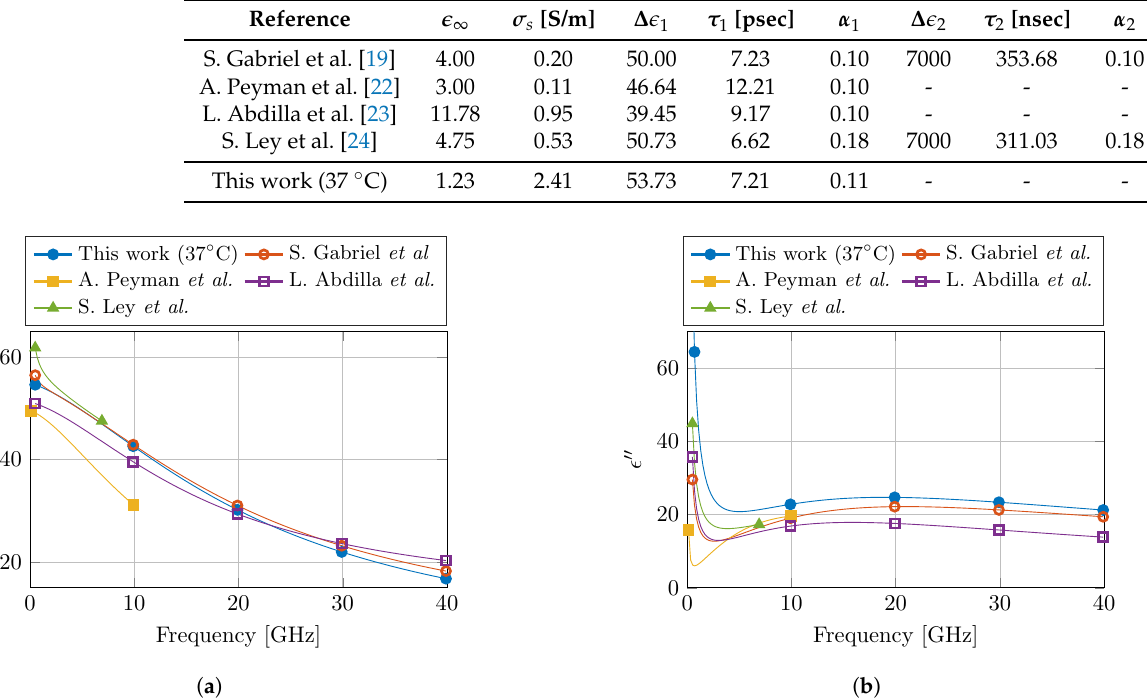
Figure 8. Comparison of the proposed dielectric model of muscle tissue at 37 ◦ C with the models from literature in the corresponding frequency range. The real and imaginary part of the permittivity are shown in ( a , b ), respectively. (Literature data from S. Gabriel et al. [19], A. Peyman et al. [22], L. Abdilla et al. [23], and S. Ley et al.